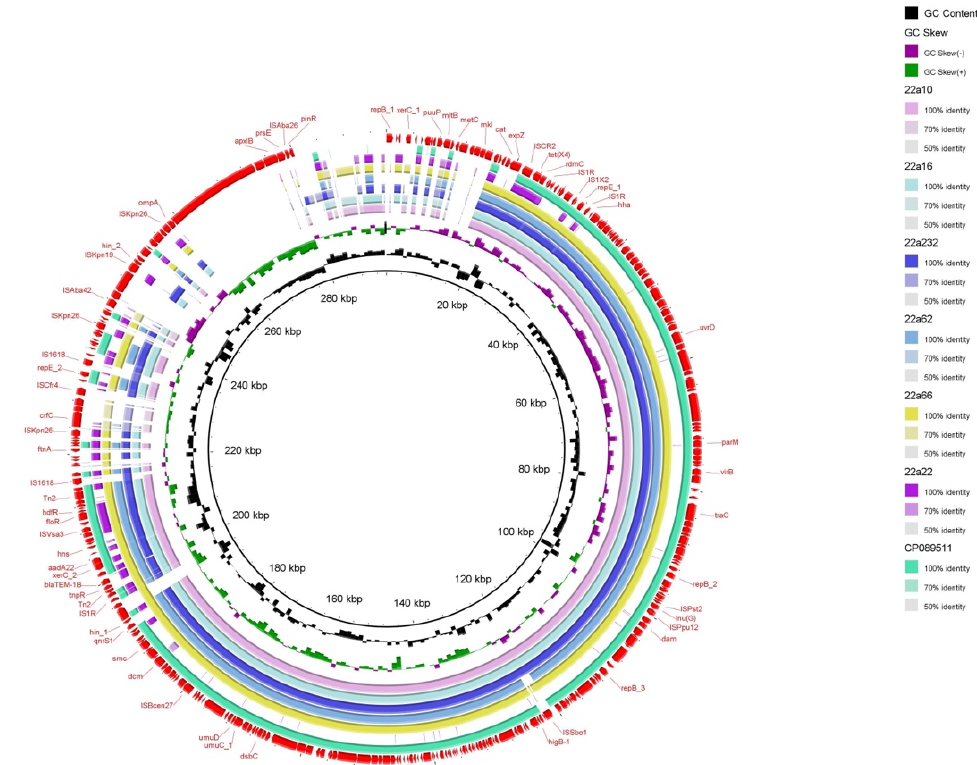
Figure 2. Circular comparison of the tet (X4) − bearing plasmids with other closely related plasmids pRT18 − 1 (MT219824) from the NCBI database. The outmost ring represents the reference plasmid with its gene positions.